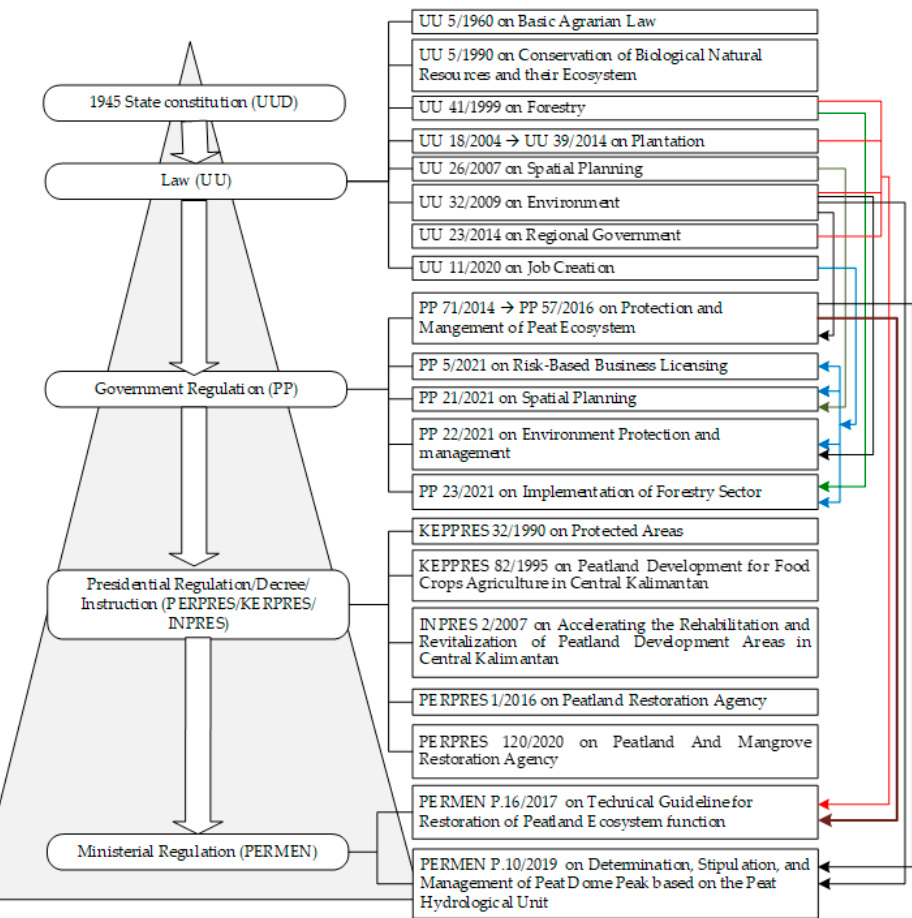
Figure 2. Hierarchy of the legal system of peatland restoration in Indonesia. The legal system includes 8 laws, 5 government regulations, 2 presidential decrees and one presidential instruction as the legal basis for 6 decades of peat management and restoration. (The colour of the arrows shows the derivative rules).